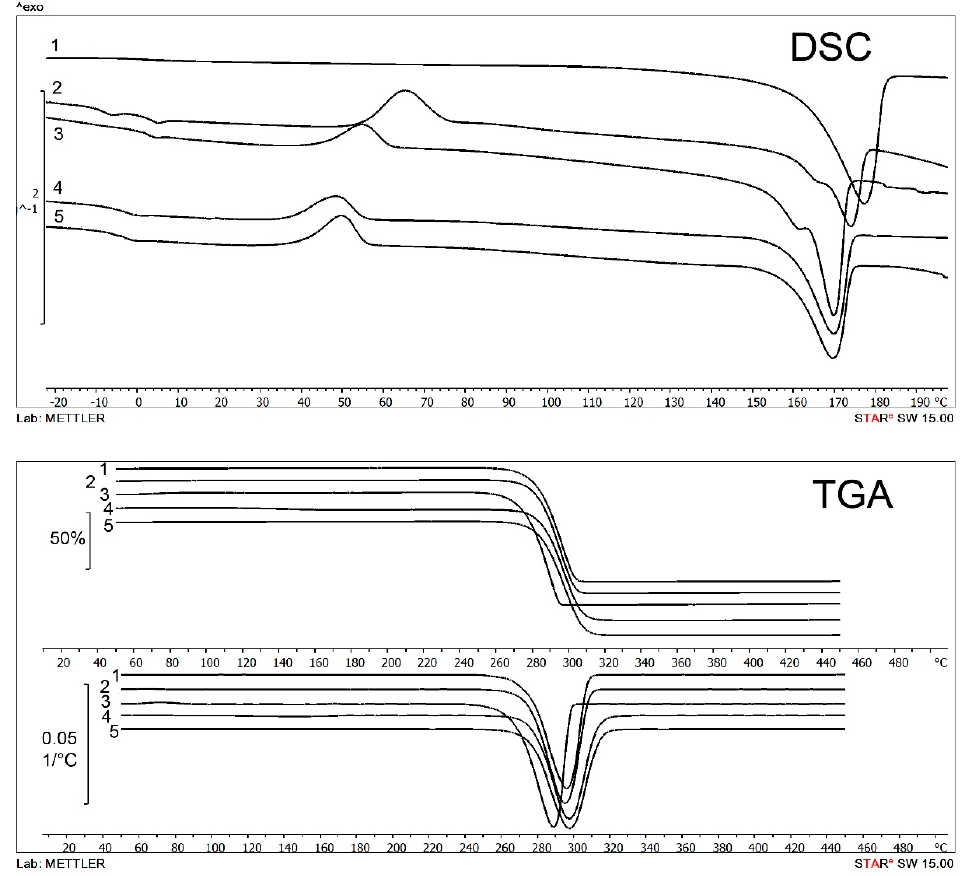
Figure 5. Results of thermal analysis of PHAs synthesized by Cupriavidus necator B-10646 from hydrolysates of JA tubers. 1-P(3HB), 2-P(3HB-co-37.4 mol.%3HV), 3-P(3HB-co-9.9 mol.%3HV), 4- P(3HB-co-11.9 mol.%4HB), 5-P(3HB-co-21.1 mol.%4HB).